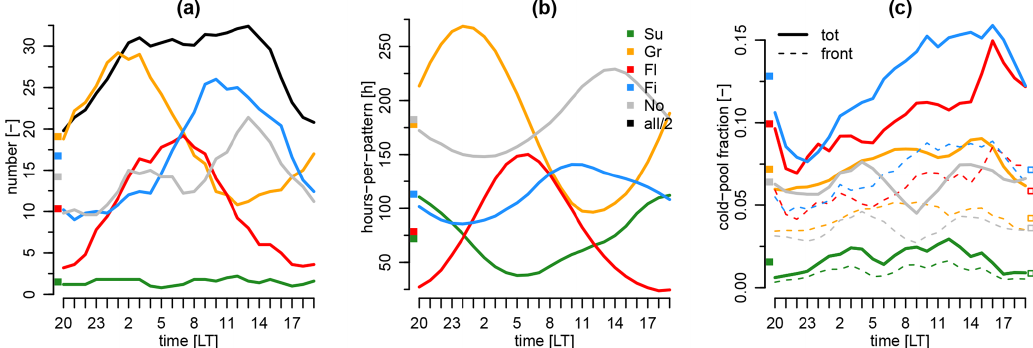
Figure 9. Daily cycles of (a) number of cold pools, (b) hours of data for the different organization patterns, and (c) hourly fraction in cold pool (solid) and in cold-pool front (dashed). A 5-hourly running mean is applied to smooth the data. The diel means are indicated on the left-hand side of each